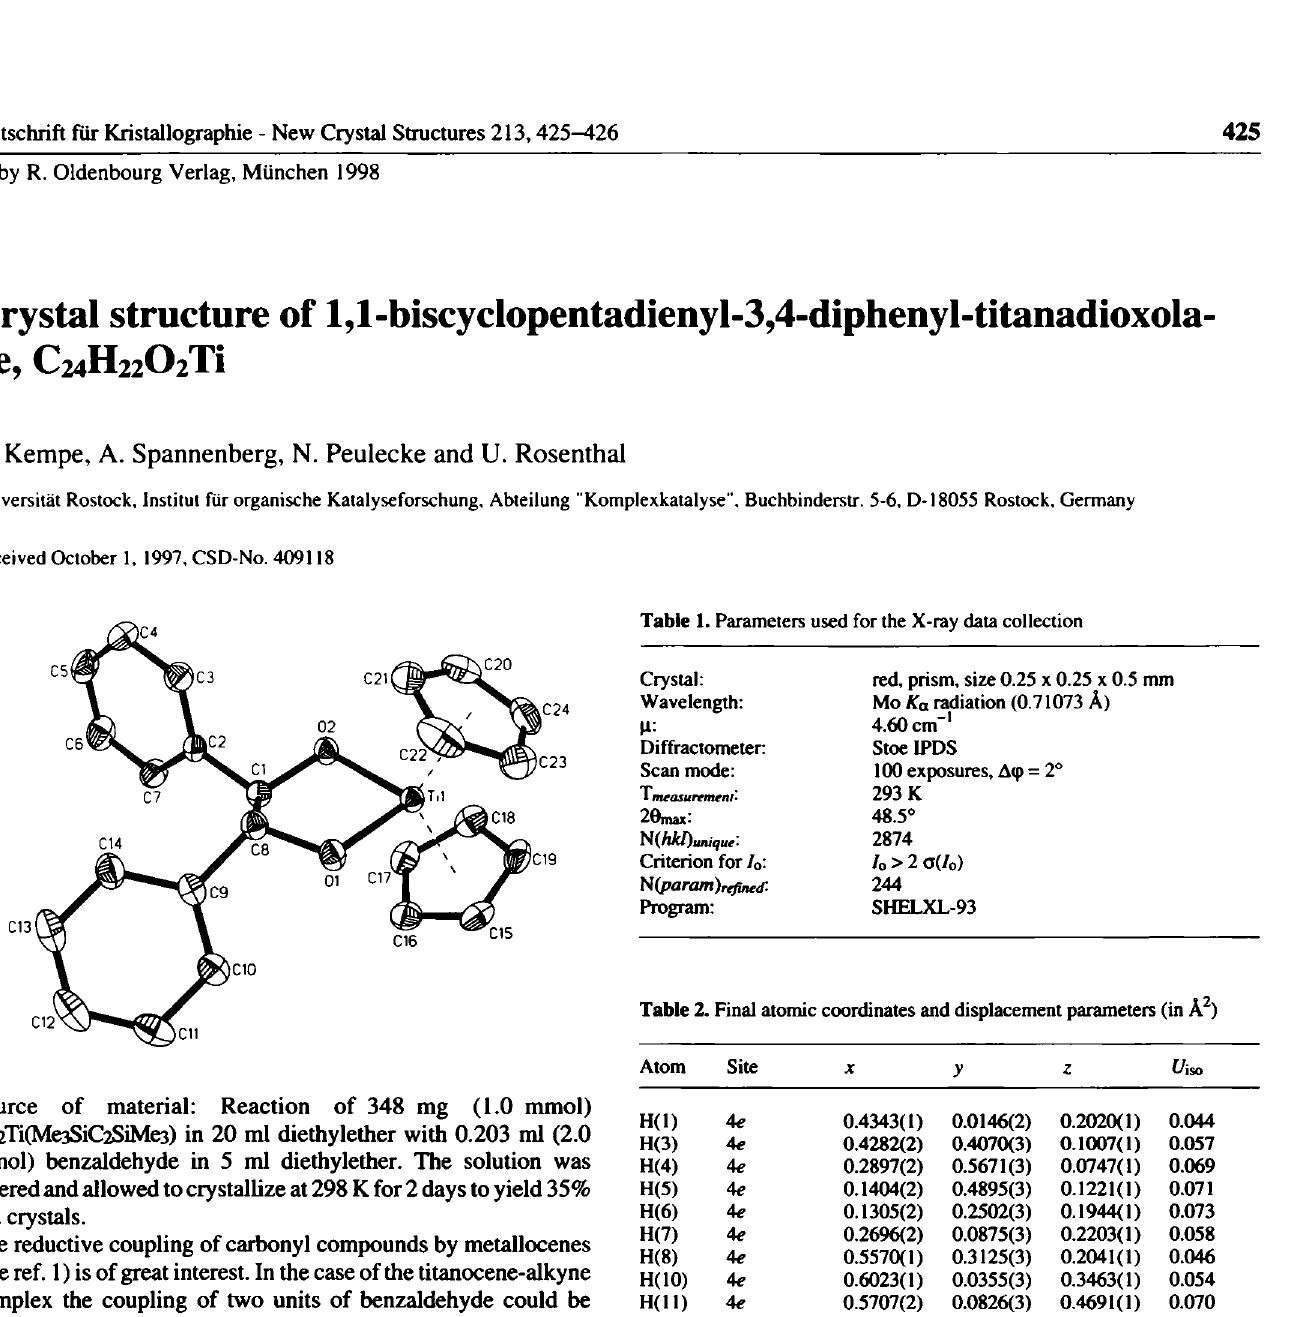
Table 2. Final atomic coordinates and displacement parameters (in